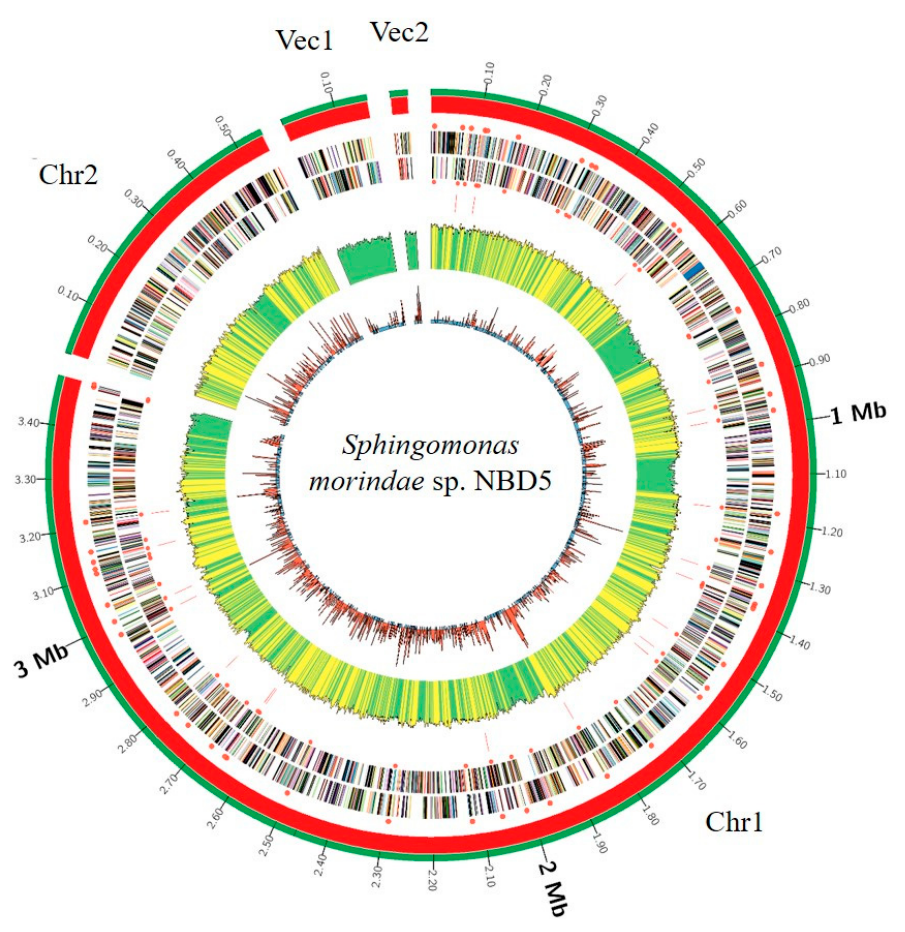
Figure 1. Circular representation of two chromosomes and two plasmids of Sphingomonas morindae sp. NBD5. Marked information is illustrated from the inner to outer ring: GC skew, GC content, the distribution of rRNAs and tRNAs, CDSs on the reverse stand, CDSs on the forward stand, genomes size. Table 1. Genome features of Sphingomonas morindae sp. NBD5.